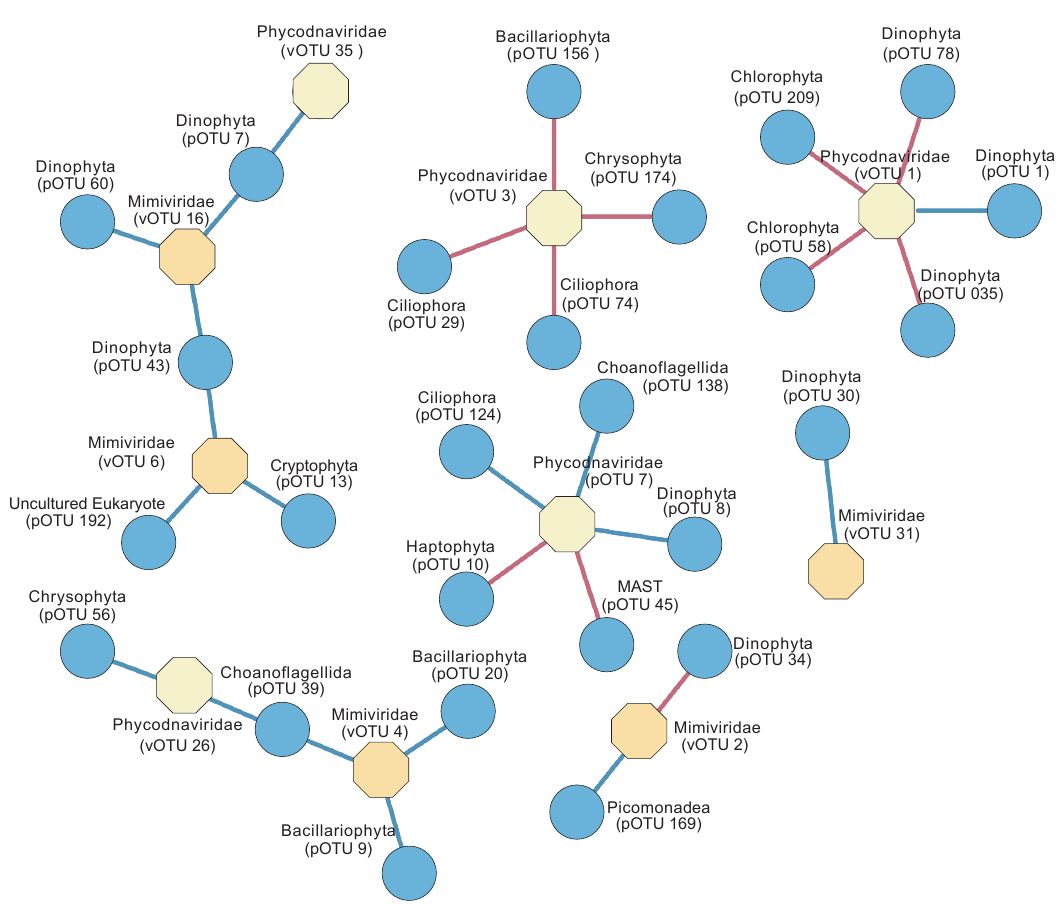
Figure 4. Network analysis showing the co-occurrence between virus and protist taxa (represented as blue and beige nodes respectively). Lines between nodes indicate positive (blue) and negative (red) SparCC correlation >| 0.5 | (two-sided pseudo p-value < 0.05) between the abundances of linked taxa. Network was visualized by Cystoscape